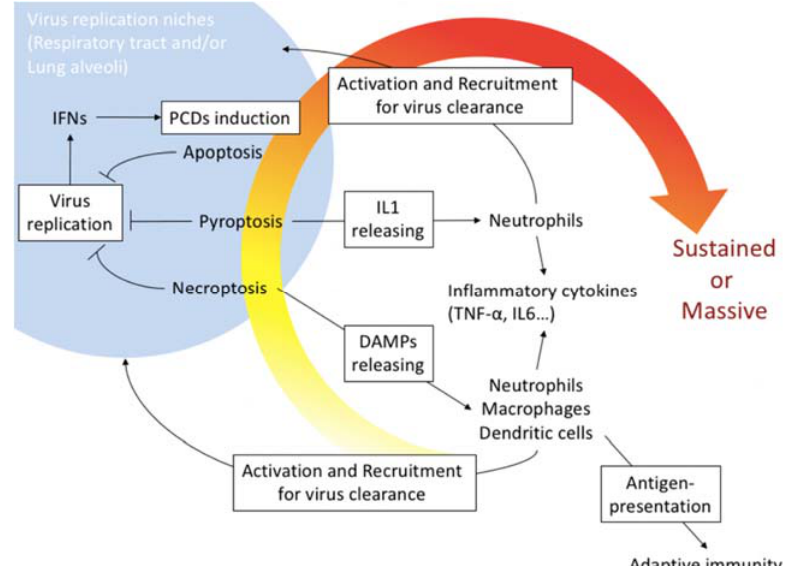
Figure 5. PCD induction in host protective immunity and pathogenicity in influenza virus infection. PCDs including apoptosis, necroptosis and pyroptosis are usually mechanisms to limit influenza virus proliferation niches. Especially, necroptosis and pyroptosis associate releasing DAMPs or IL1 that activate and recruit phagocytotic cells such as neutrophils, macrophages and dendritic cells into local virus replication area. The phagocytotic cells produce several inflammatory cytokines including TNF α and IL ‐ 6 to promote the accumulation of the cells. High yield of the virus replication often promotes and/or sustains the massive host immunoreactions that cause tissue damages and organ failure.